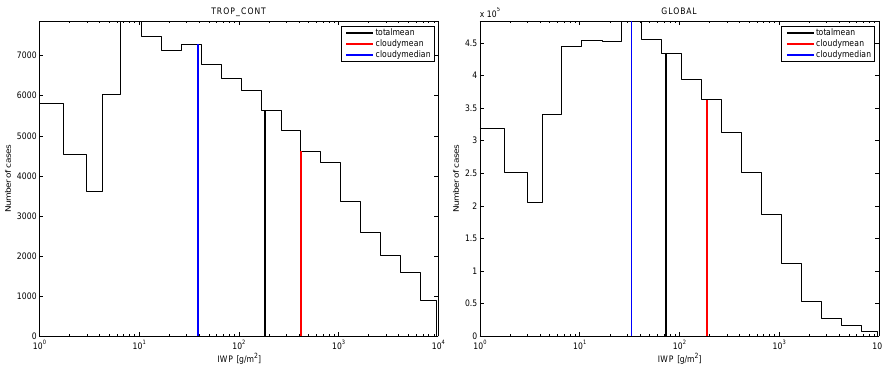
Fig. 7. Histogram of CloudSat IWP in a region of frequent strong convection (left) and the global IWP distribution (right). The region studied here is the combined region of equatorial continental convection in South America and Africa (see Fig. 9.). The IWP data (level 2, granule) are shown in intervals of log 10 ( IWP ). The sample month chosen for both histograms is March 2007. The vertical lines represent: the total mean including cloud free footprints (black), the cloudy mean excluding cloud free (red), and the cloudy median (blue) for the given